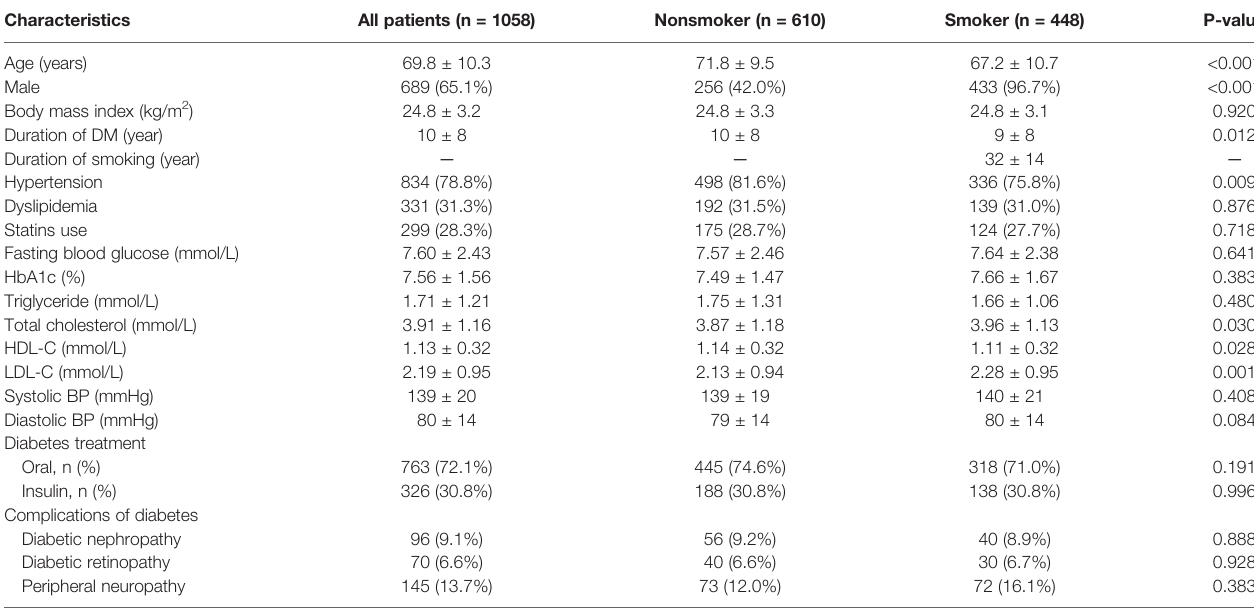
TABLE 1 | Baseline characteristics of DM patients with coronary artery plaques.